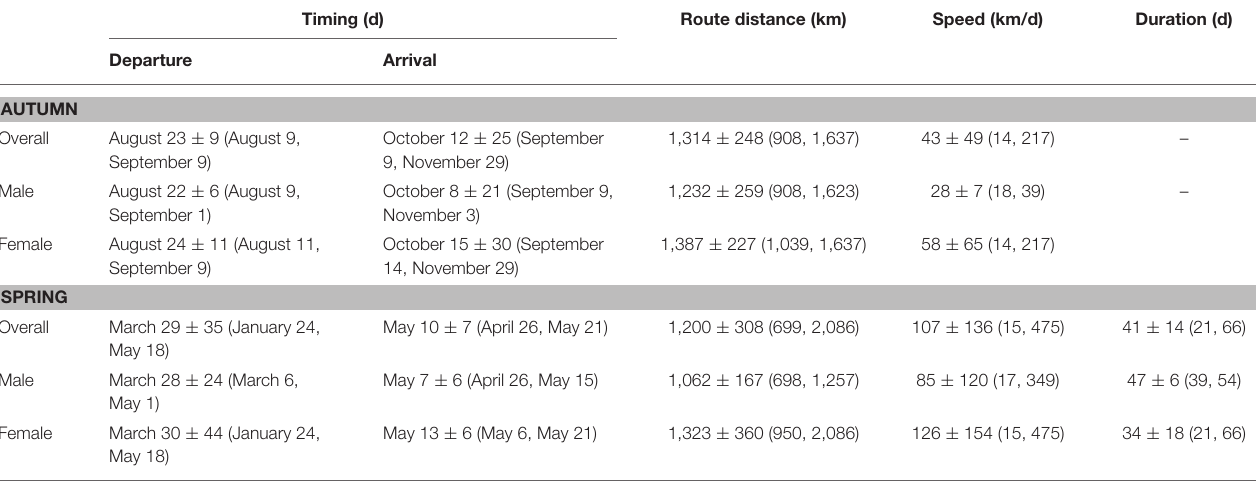
Top values are the mean ± SD, while those in brackets depict the range. The location that departure and arrival refer to depends on the migration season. For example, departure in autumn is from the breeding site, but in spring it is from the winter site. Duration refers to the staging area in spring, often in the Thompson-Okanagan or northern Columbia Plateau